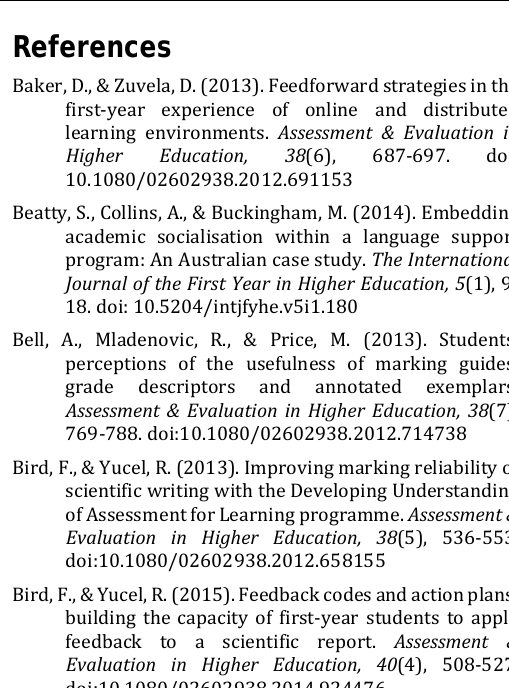
Figure 3: Revised principles for first-year